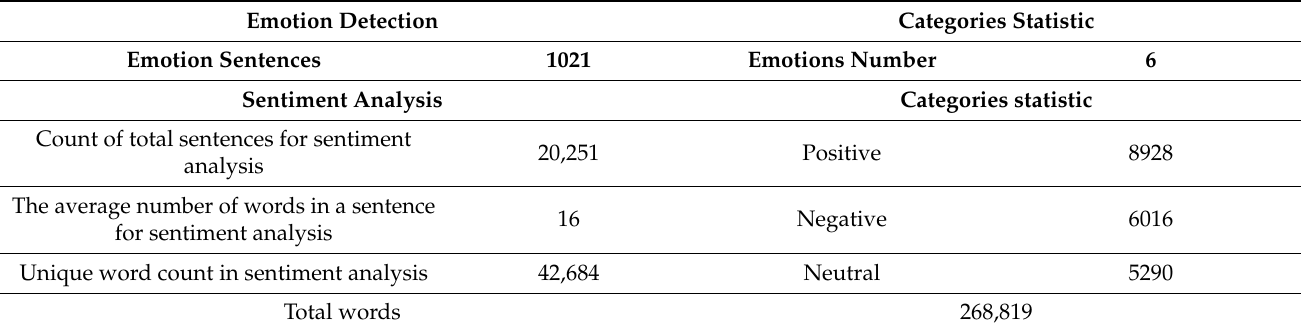
Figure 5. Training and Testing Comparison Results Sets for Emotion Detection with Different Epochs.